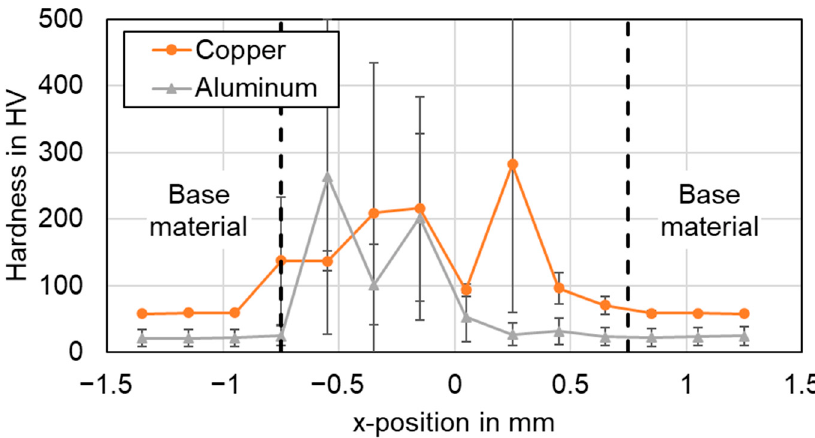
Figure 21. Microhardness profiles of the weld seam produced with circular beam oscillation using parameter set #4 ( n = 4).